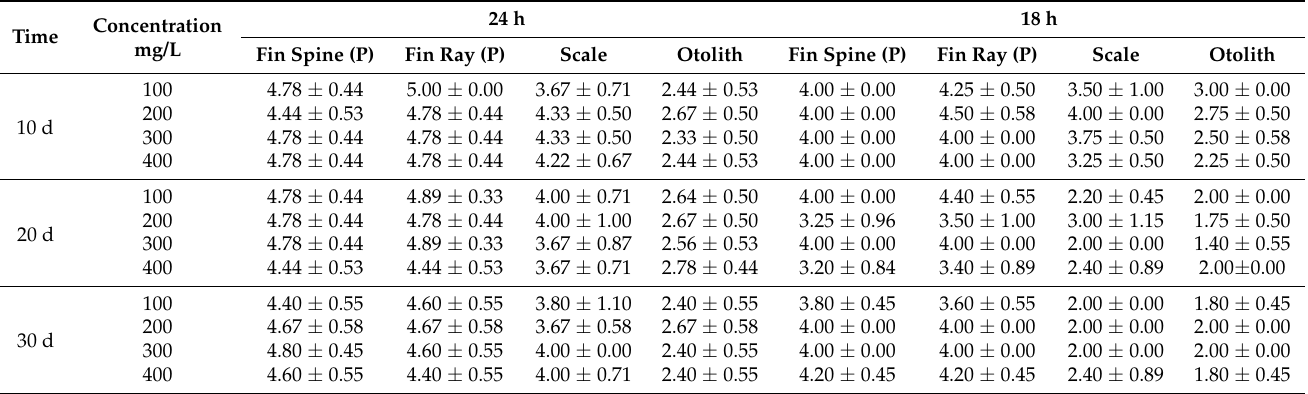
Table 4. Effects of different immersion times on marking in the fin spine, fin ray, scale and otolith of black sea bream for different concentrations of ARS.